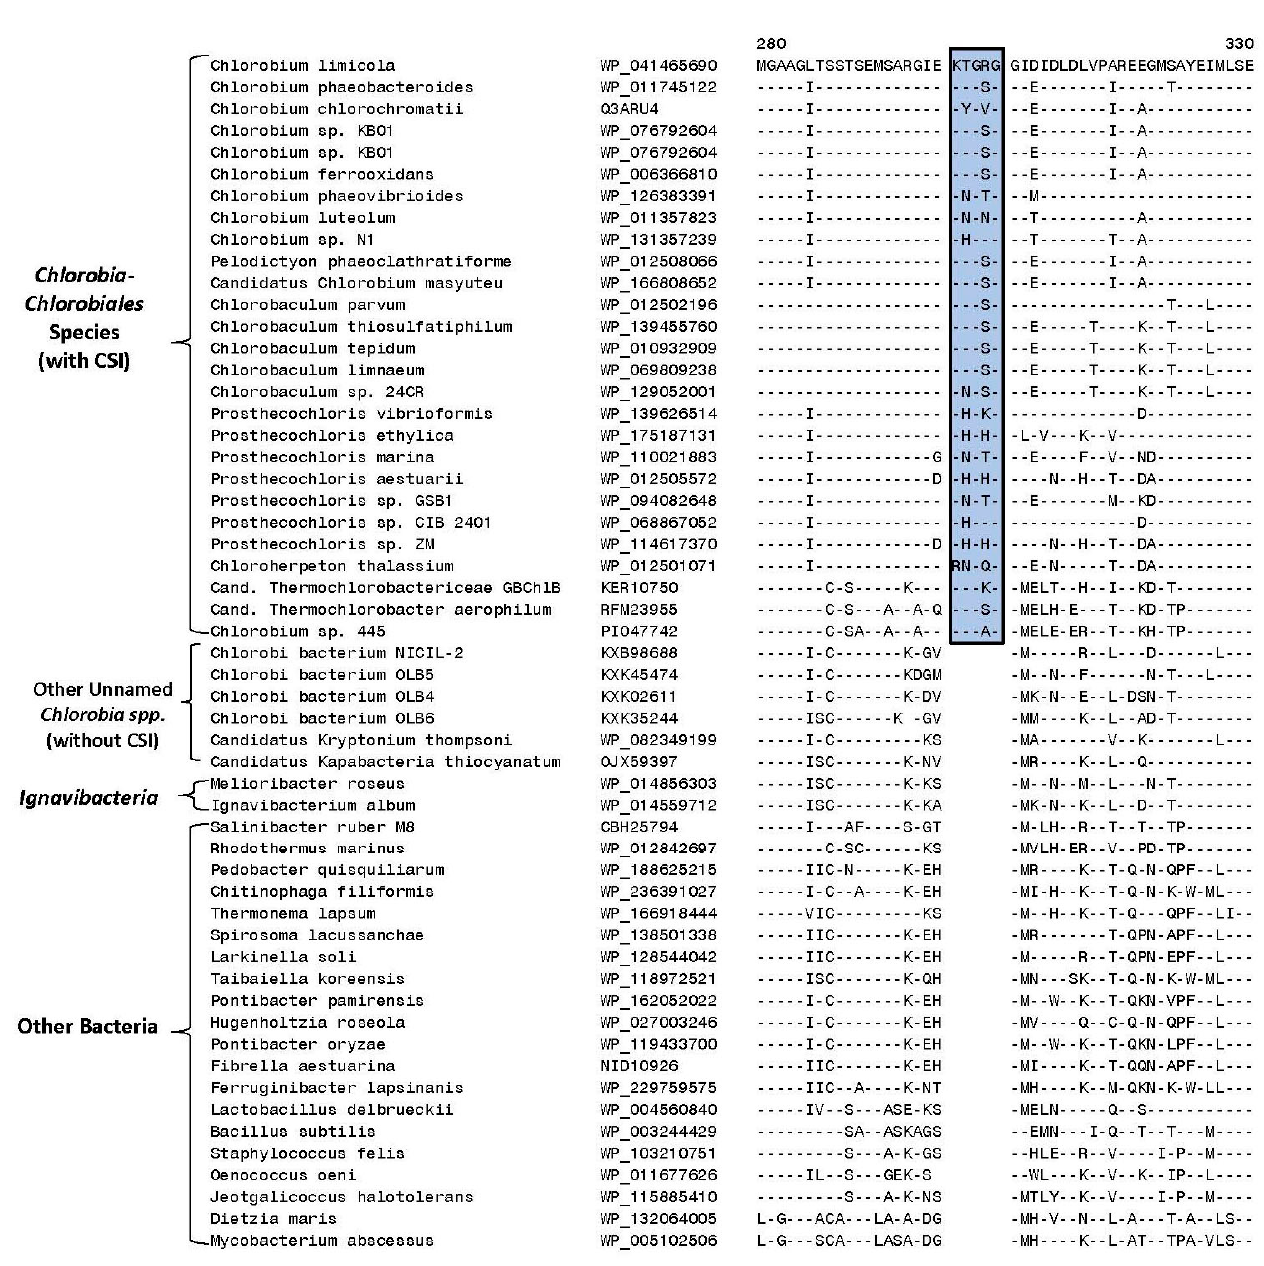
Figure 4. Partial sequence alignment of the protein phosphoribosylformylglycinamidine synthase II showing a five-amino-acid insertion (boxed) in a conserved region that is exclusively shared by all species/strains from the class Chlorobia (Figure 1). This insert is lacking in Ignavibacteria as well as other Candidatus and Chlorobi bacteria strains that do not group with the Chlorobia clade. The dashes (-) in this and all other sequence alignments indicate identity with the amino acids on the top line. Gaps in sequence alignment indicate that no amino acid is present in that position. Accession numbers for different sequences are indicated in the second column and the position of this sequence fragment within the protein is indicated above the sequences.